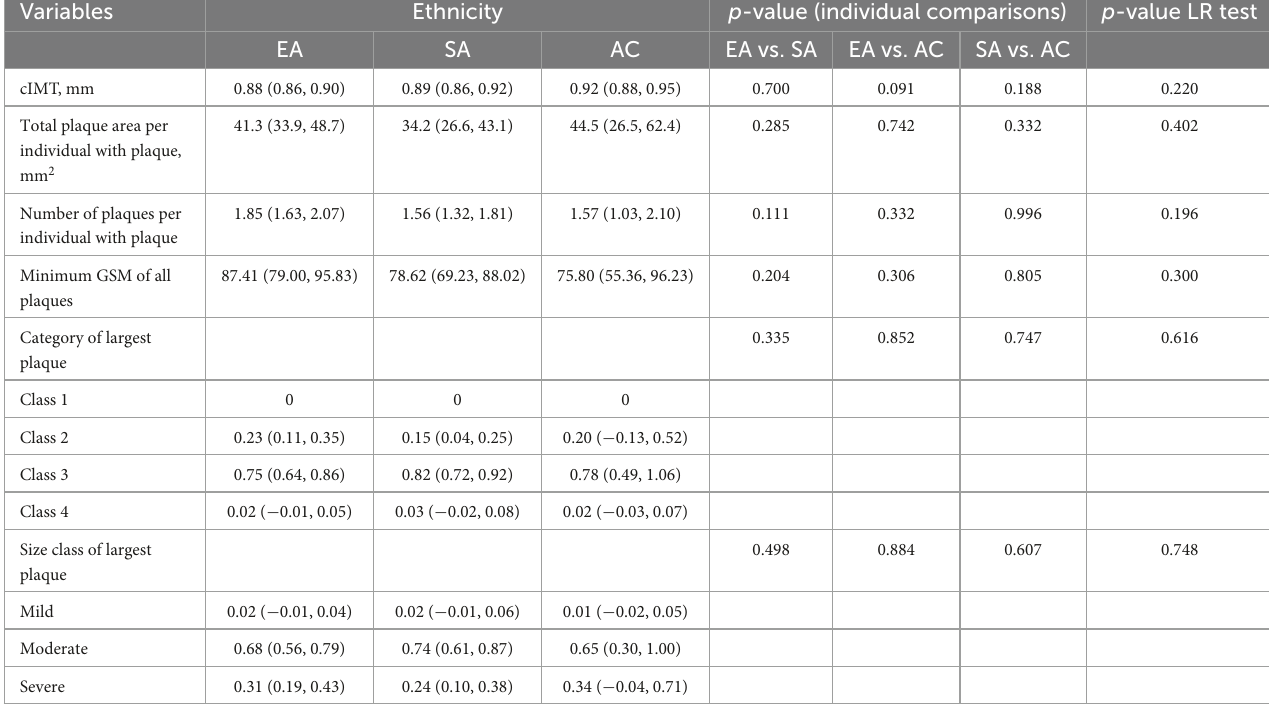
TABLE 4 Ethnic differences in cIMT and plaque characteristics with adjustment for non-modifiable and modifiable risk factors (Model 2). Variables